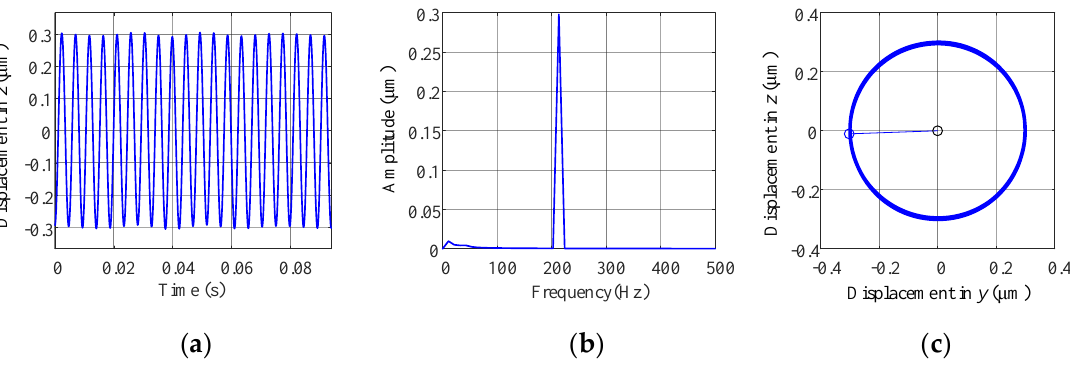
Figure 13. Vibration response under speed of r n = 12,800 r/min and unbalanced mass of m e = 4 × 10 − 5 kg · m. ( a ) time domain response; ( b ) frequency domain response; ( c ) displacement.